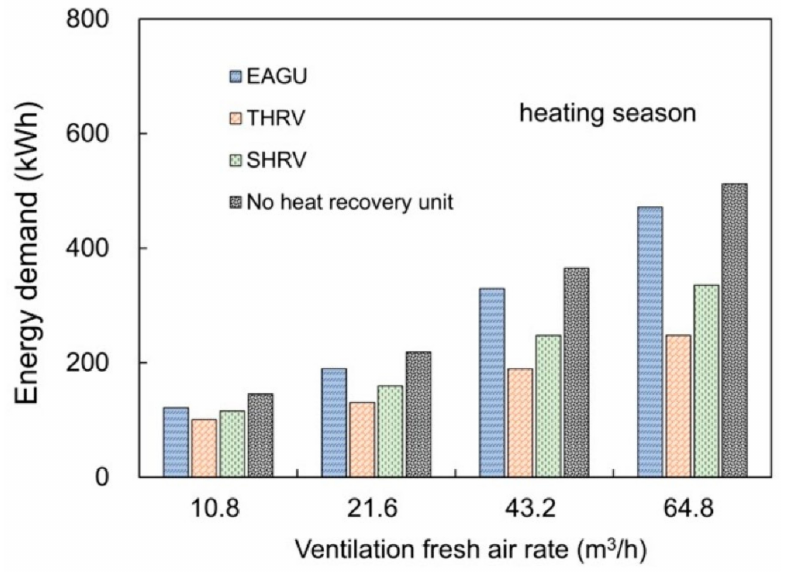
Figure 21. Yearly energy demand for ventilation using different heat-recovery systems: EAGU = exhaust air glass unit, THRV = conventional total heat recovery ventilator, SHRV = sen- sible heat recovery ventilator